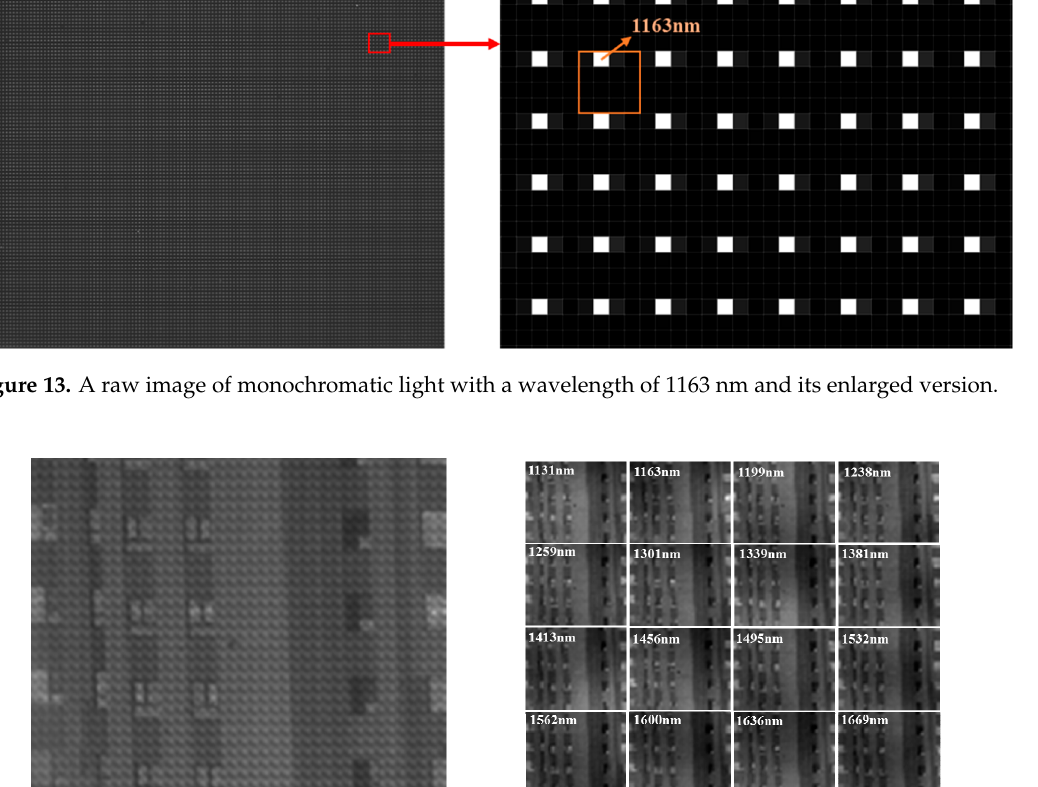
Figure 14. ( a ) Raw master image and ( b ) spectral images of the corresponding filters extracted from the raw master image.